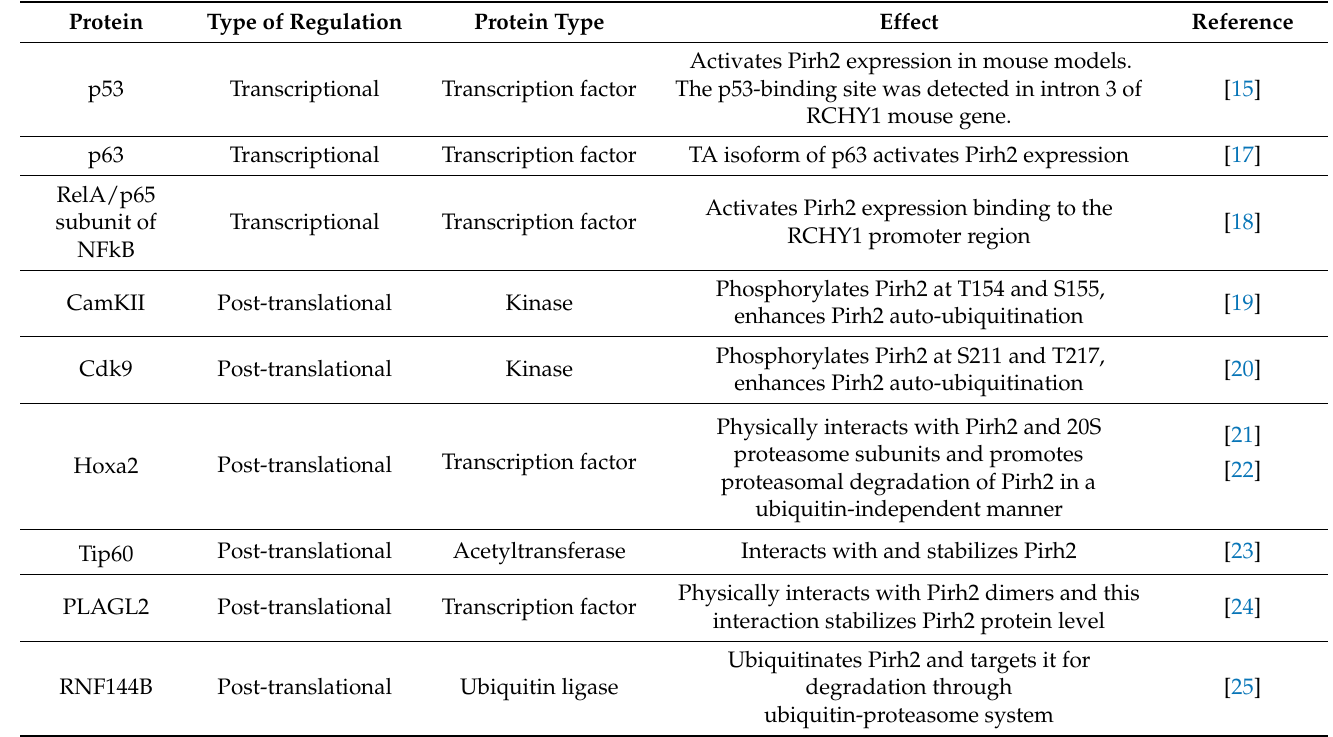
Table 1. Pirh2 regulating